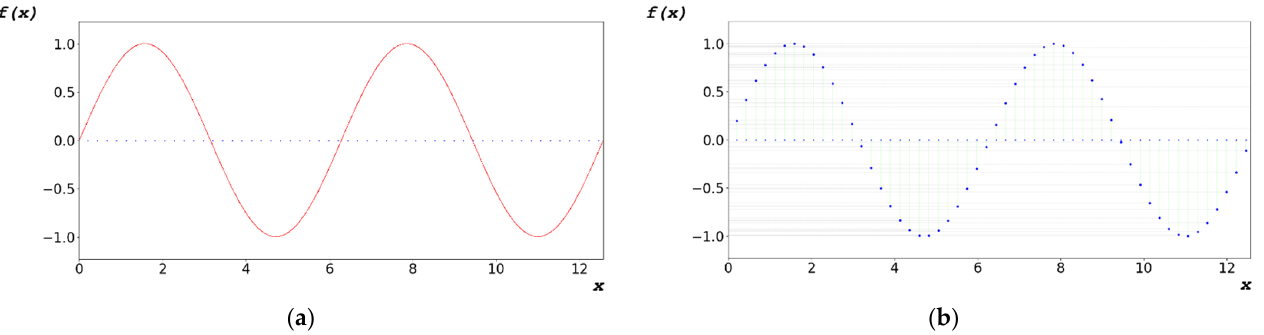
Figure 6. ( a ) Determination of independent variables at regular intervals (dx) for generating random bits in periodic functions; and ( b ) set of non-overlapping dependent variables based on selected independent variables.